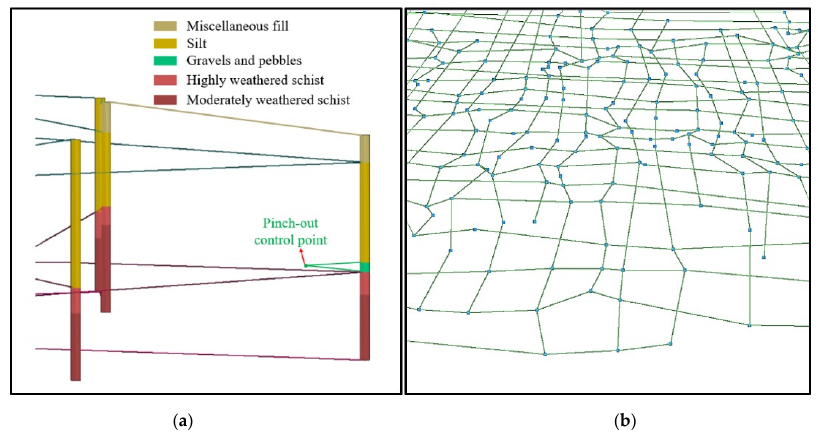
Figure 13. ( a ) Side-view of stratum connection. ( b ) Schematic diagram of connecting borehole points.